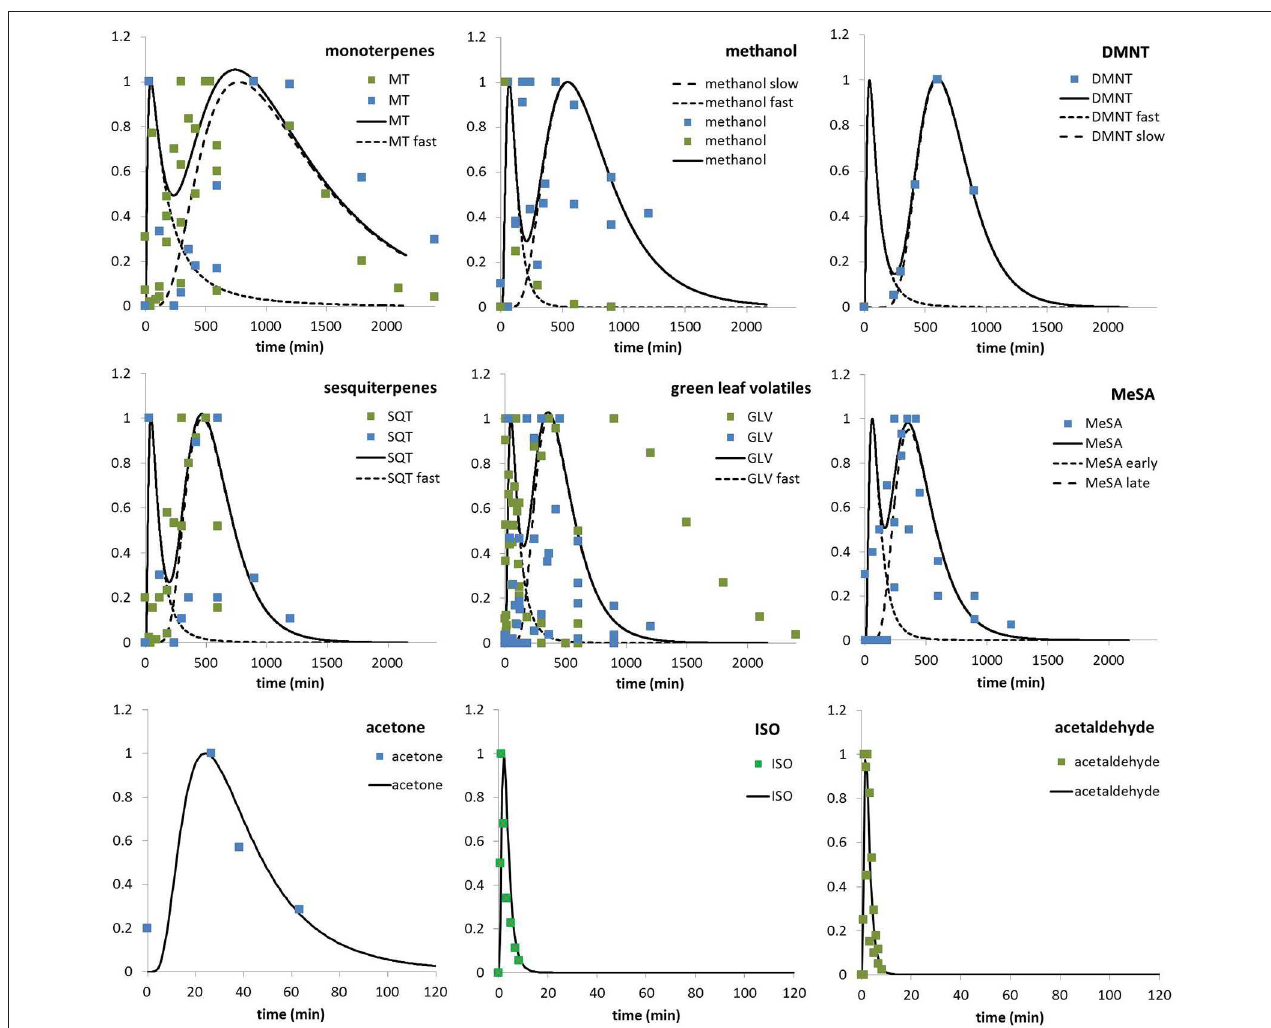
FIGURE 3 | Normalized temporal development of emissions in response to induced ozone (blue dots) and herbivory (green dots) stress as derived from 13 publications (5 for ozone, 7 for herbivory, and one for both). Lines are representing simulated transients of emissions. In case of bi-model developments, the single representations for slow and fast responses are separately normalized as indicated with broken lines. Compounds are sorted according to response time. It should be noted that the last row is given in a different temporal scale than the rows above. See text for literature